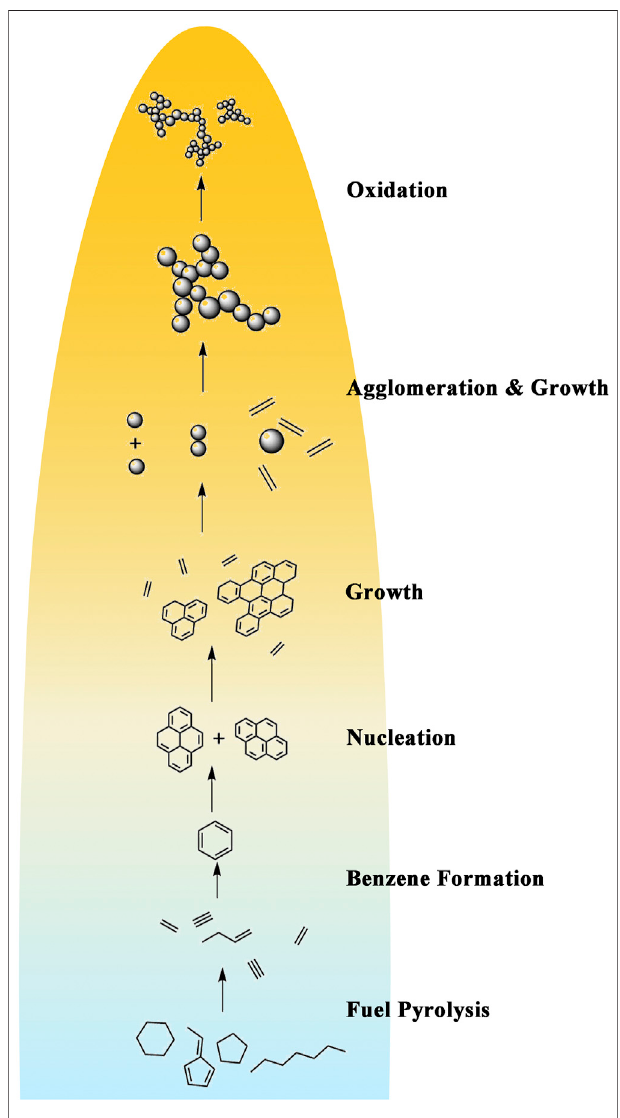
FIGURE 1 | The physical and chemical processes of soot